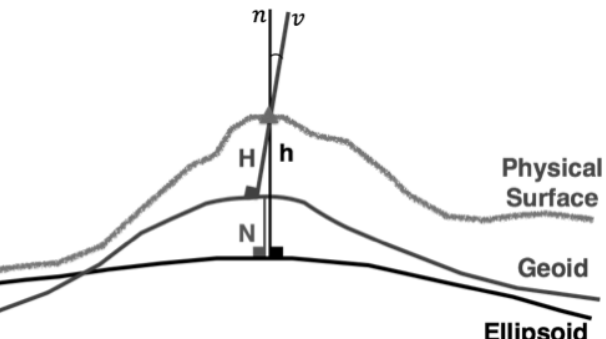
Figure 1 - Physical, geoid and ellipsoid surface (see the colors in the online